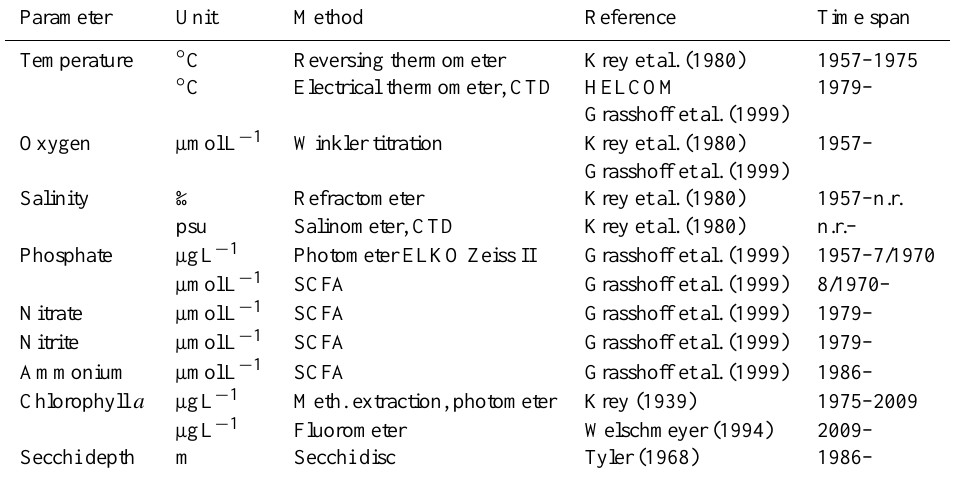
Table 1. Synopsis of methods used for determining oceanographic parameters at the Boknis Eck time series station since 1957. n.r.: not reported; CTD: conductivity, temperature, depth; SCFA: segmented continuous flow analyser; Meth.: